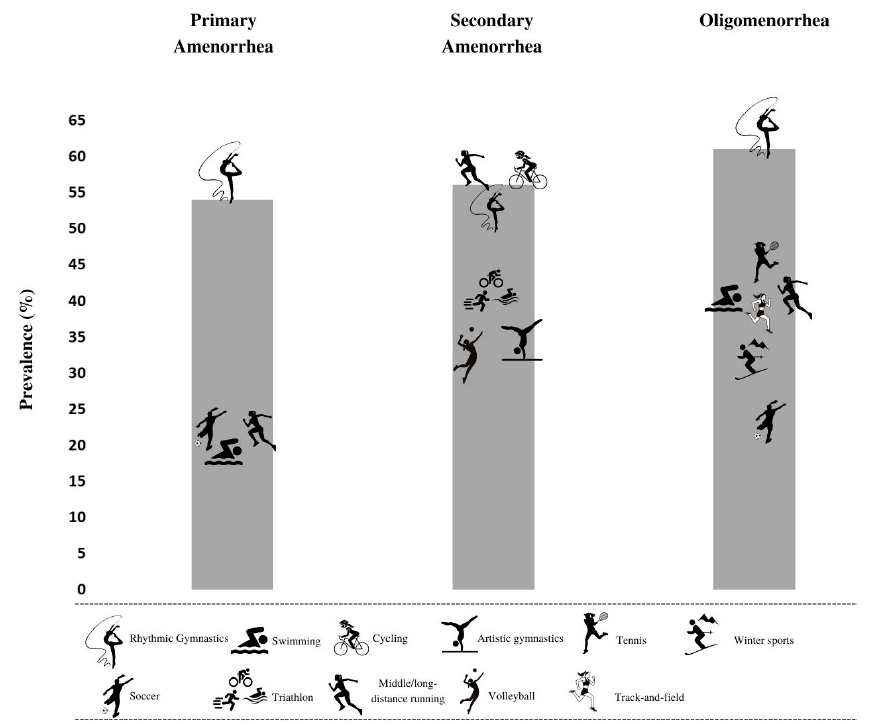
Figure 2. Sports disciplines with the highest prevalence of primary, secondary amenorrhea and oligomenorrhea.